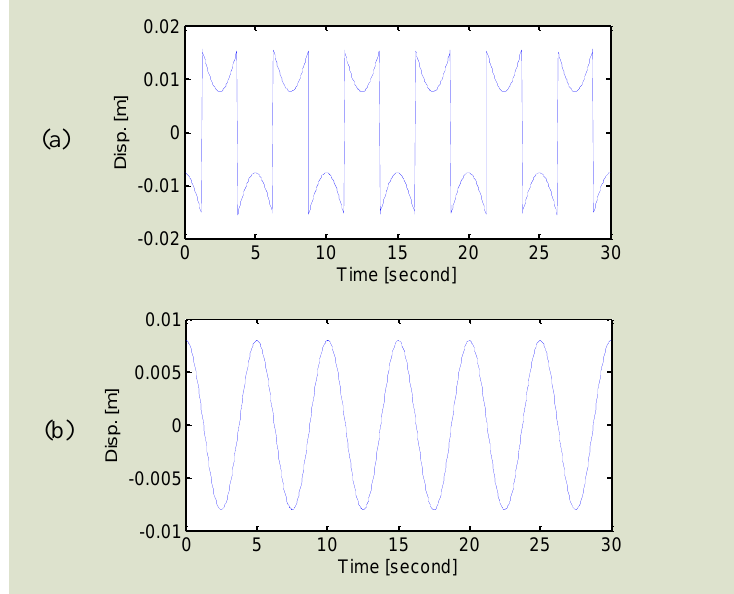
Figure 5. Demodulation of a 0.2 Hz 16 mm displacement movement in 2.4 GHz Doppler radar using ( a ) regular arctangent demodulation, and ( b ) extended DACM algorithm. Phase discontinuity is seen in ( a ) because the phase exceeds the range of ( ´ π /2, + π /2).